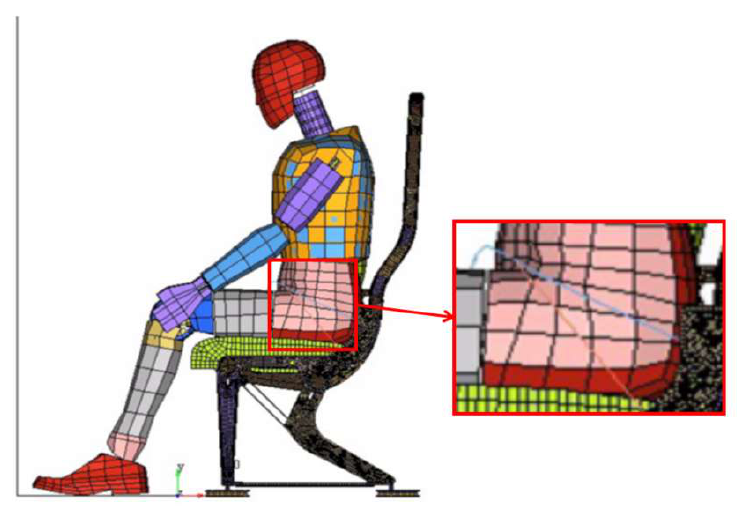
Figure 7. New FE model with modified belt.